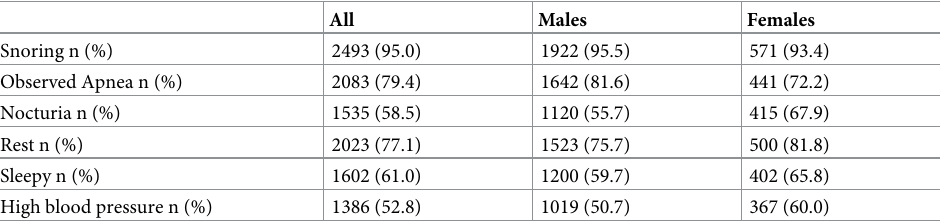
Table 2. Positive response of SANReSP.